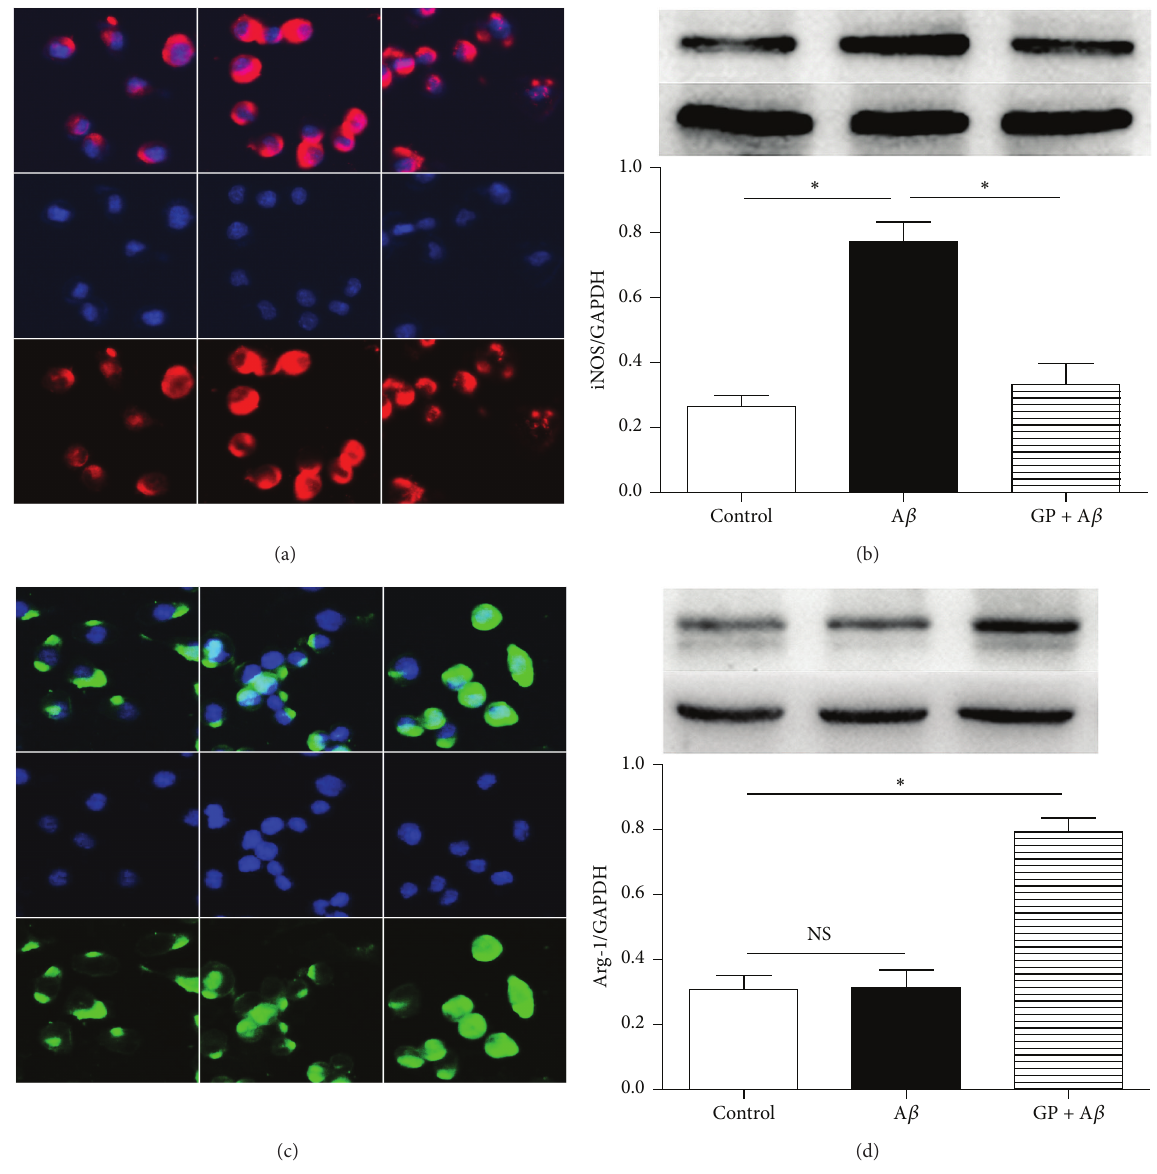
Figure 3: GP abolished A 𝛽 -induced effects on iNOS and Arg-1 expressions. The N9 microglial cells were divided into three groups, including control: cells cultured in normal medium; A 𝛽 : cells cultured in the medium containing 10 𝜇 M A 𝛽 ; GP + A 𝛽 : cells cultured in the medium containing 50 𝜇 g/mL GP and 10 𝜇 M A 𝛽 . After 24-h incubation, western blot ( 𝑛 = 4 ) and immunocytochemistry were taken to determine the iNOS (a-b) and Arg-1 (c-d) expressions. Data are means ± SD, ∗ : 𝑃 < 0.05 , NS: no